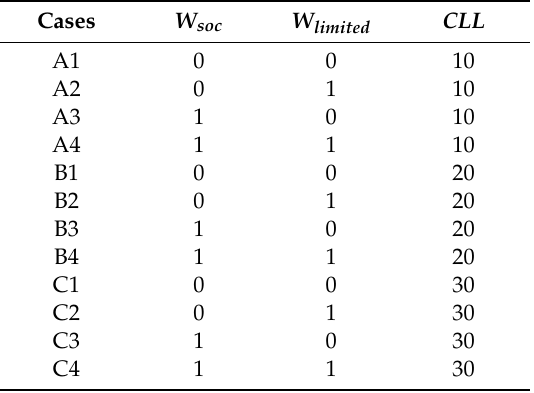
Table 4. Weights and calendar limit life for each